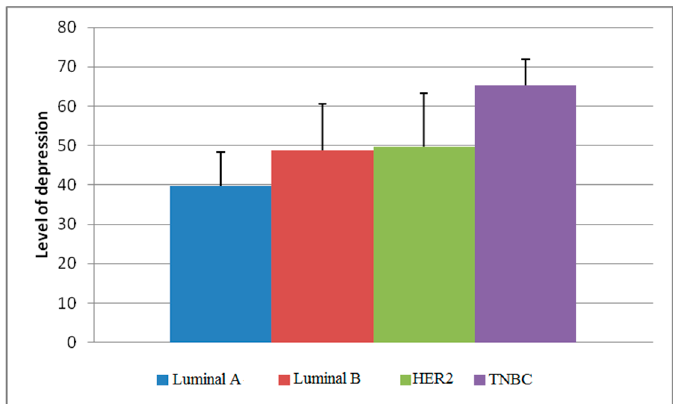
Figure 3. The difference between the mean values of the level of depression between the immunophenotypes.